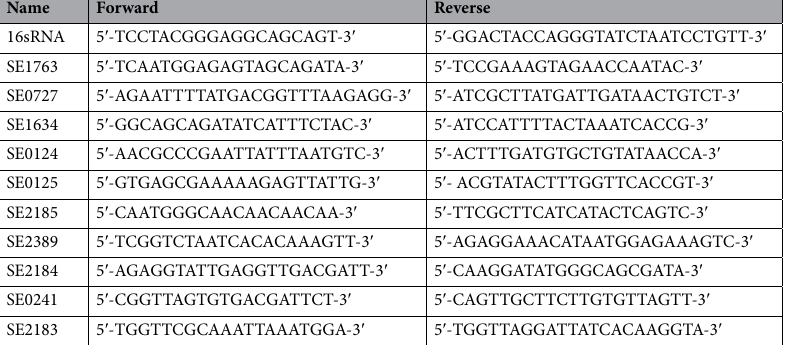
Table 2. Primers of validated genes.